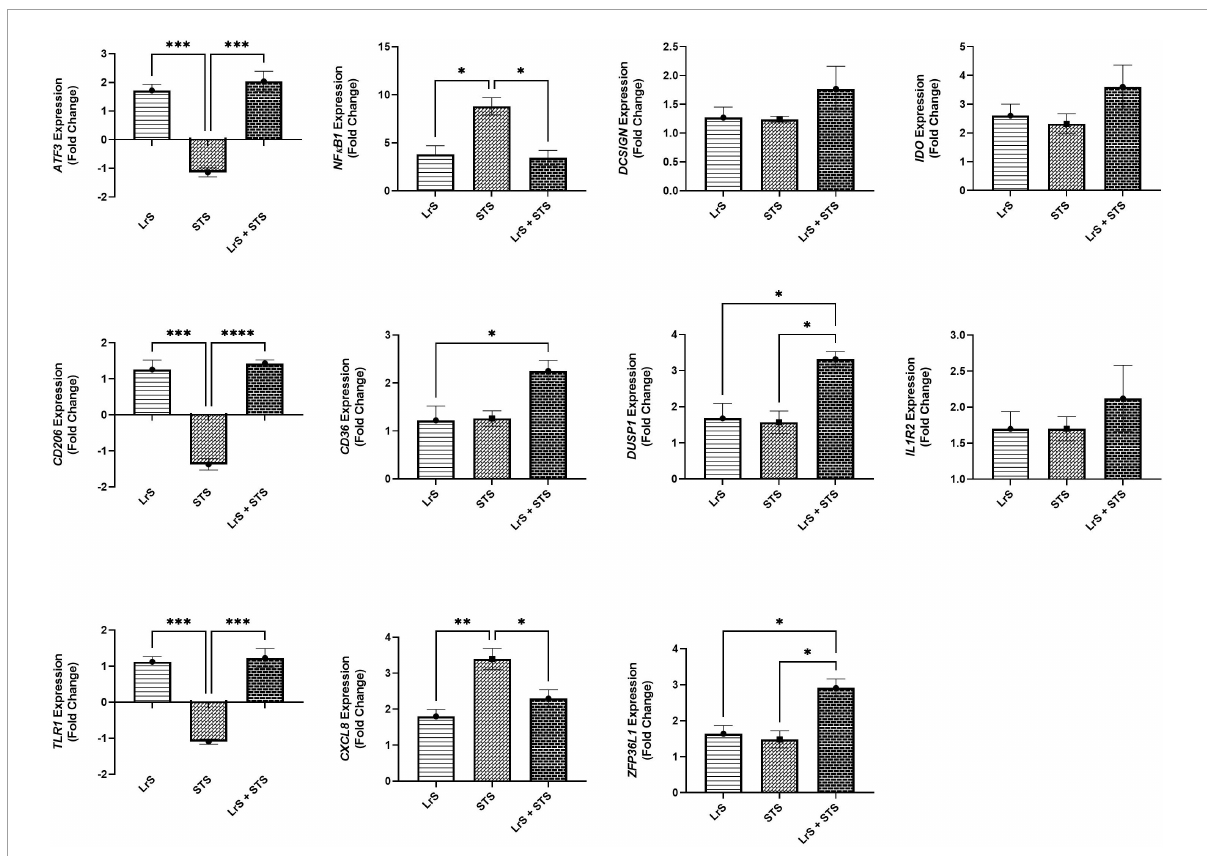
FIGURE4 Gene expression profiles of THP-1 monocytes in T84 IEC/THP-1 monocyte co-cultures challenged with the LrS, STS, or a combination of the challenges. Data shown is the mean fold-change relative to untreated controls ± SEM ( n = 4). Significance is indicated as ∗ p < 0.05, ∗∗ p < 0.01, ∗∗∗ p < 0.001, ∗∗∗∗ p < 0.0001 as determined by one-way ANOVA and Tukey’s post-hoc